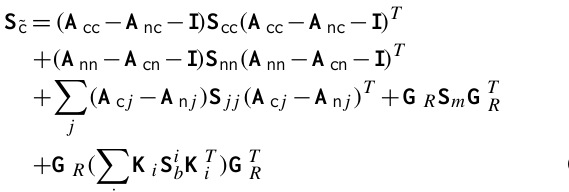
Figure 11: (Top) TES estimated methane at 562 hPa. (Bottom) TES estimated methane at approximately 500 hPa using an “information” averaging approach.